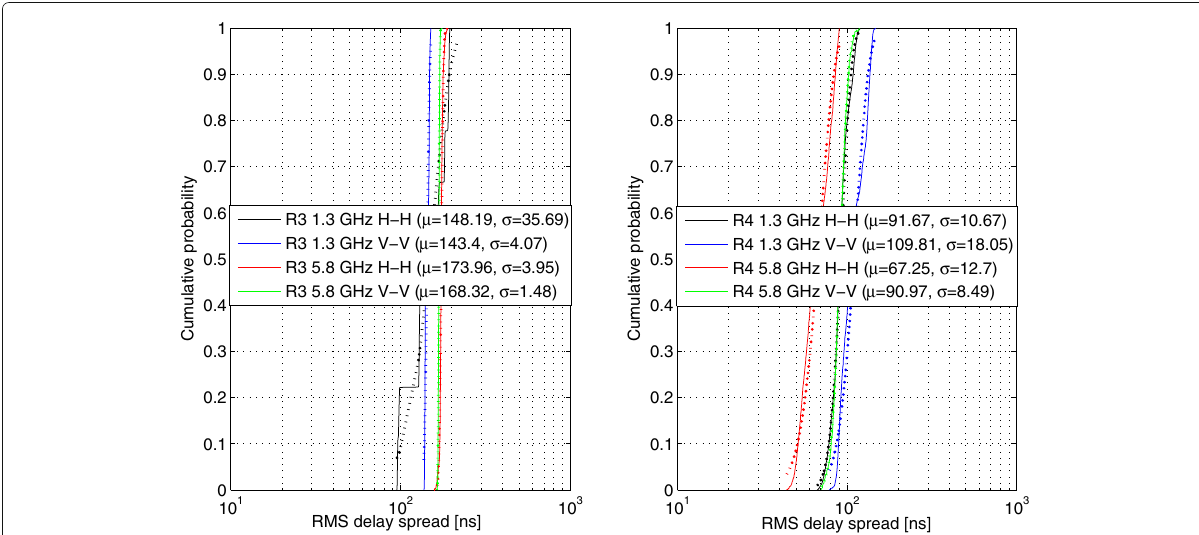
Fig. 10 R3 and R4 root mean square delay spread. Cumulative distribution function of root mean square delay spread in [ns] for different frequencies and both horizontal and vertical co-polarizations captured for the third and fourth measurement routes (R3 and R4). The colored dotted lines represent the normal distribution of the corresponding frequency and polarization